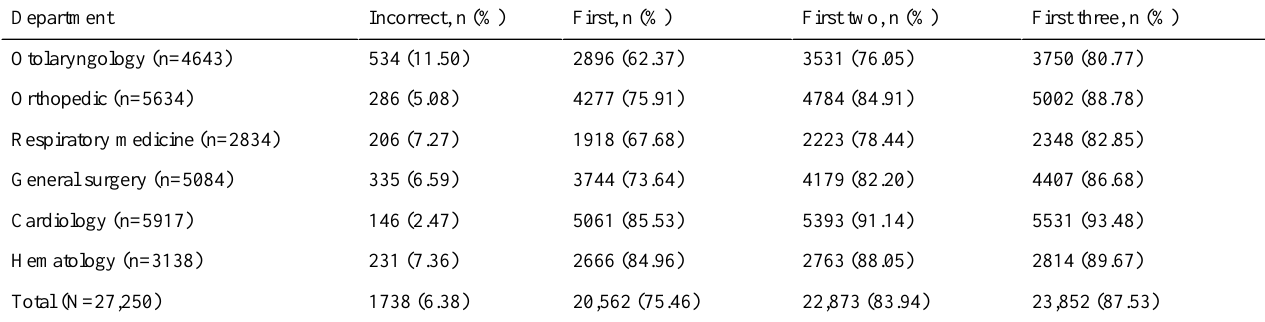
Table 2. Accuracy rates of the recommended diagnosis by clinical decision support systems across each department.